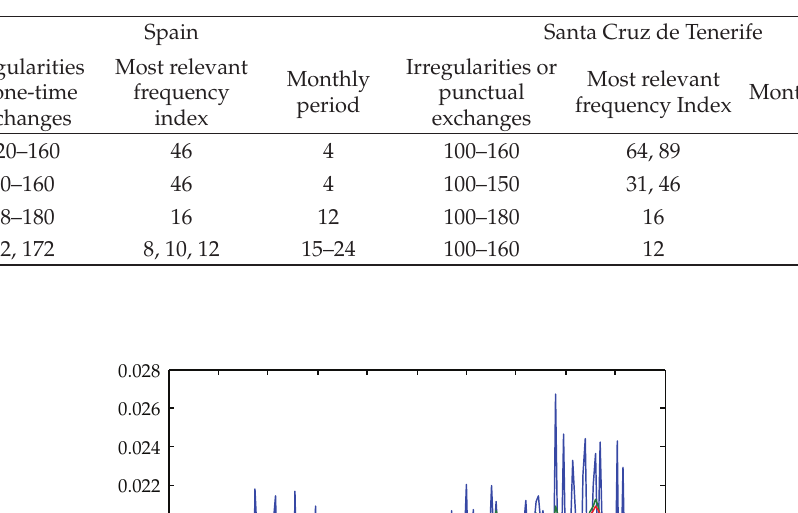
Table 5: Relevant frequency indices of Spain INDEX and SCTfe INDEX. Comparison.